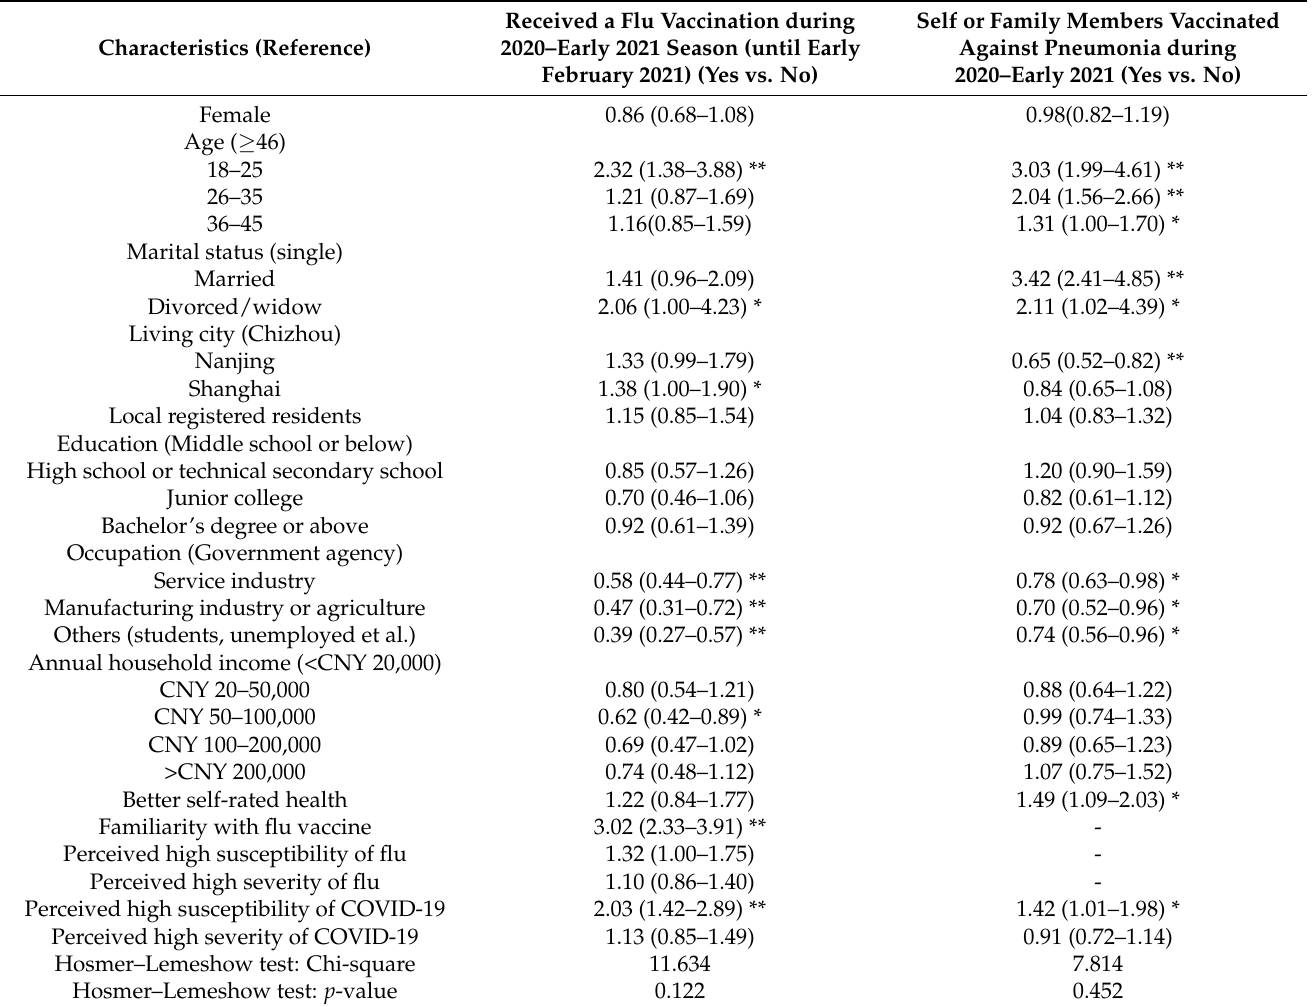
Table 2. Factors associated with flu and pneumonia vaccination uptake by multivariable logistic regressions.